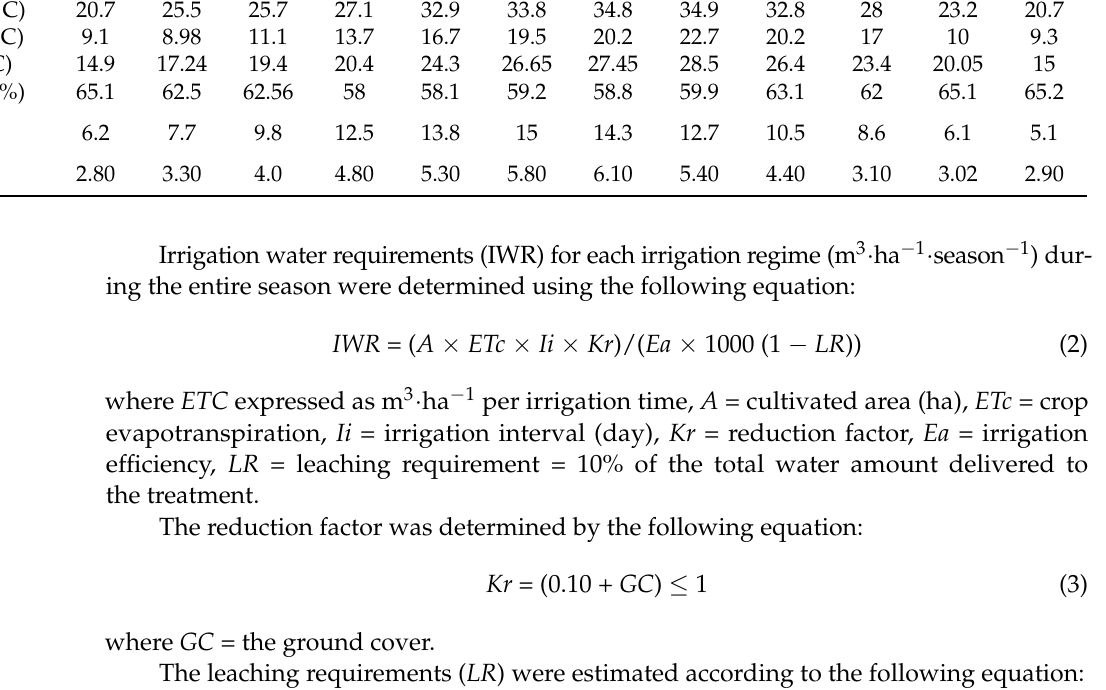
Table 2. Average meteorological data of Wadi El Natrun area (2020 and 2021), source: own elaboration. Jan